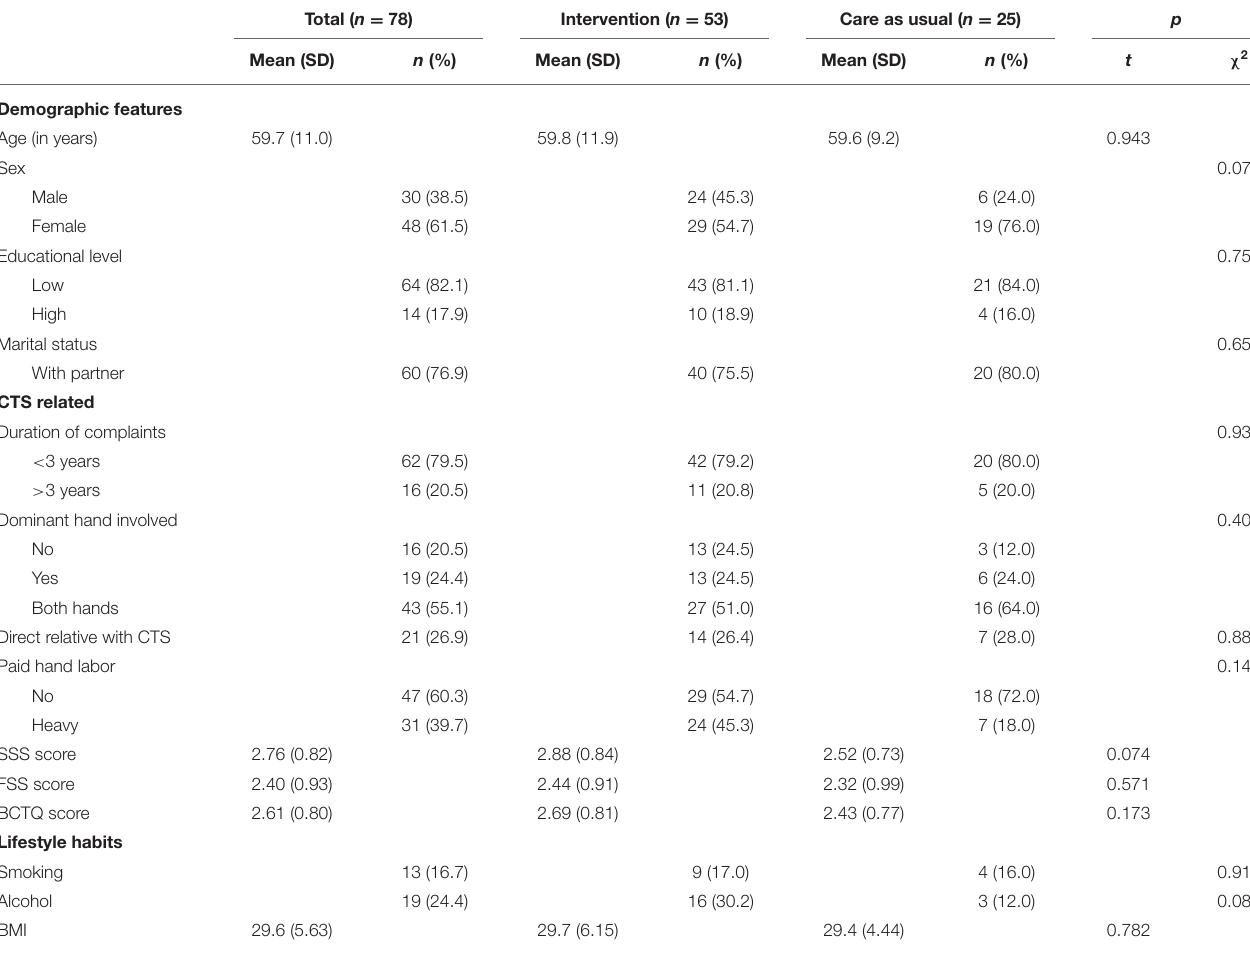
TABLE 1 | Baseline characteristics of the 78 participants who did not receive surgery at the 12-month